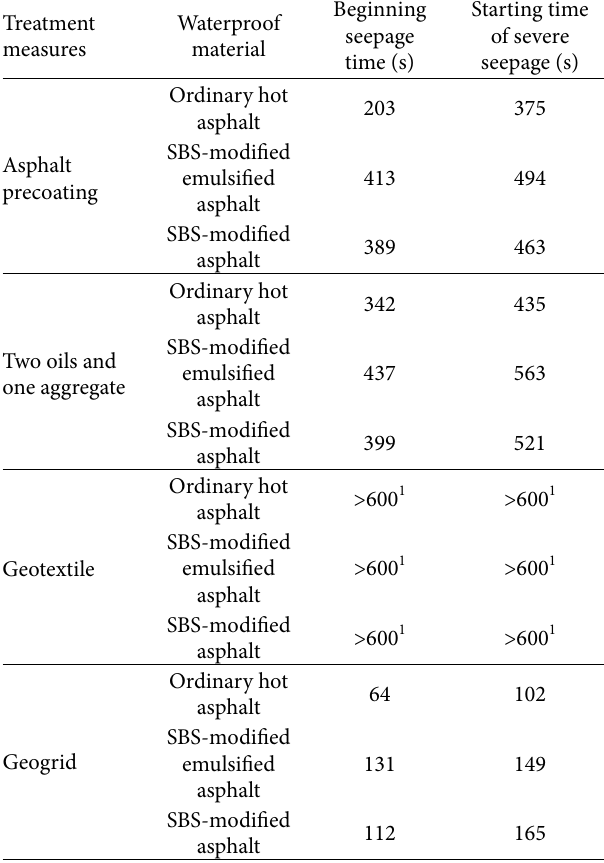
Table 13: Test results of pressure seepage between different